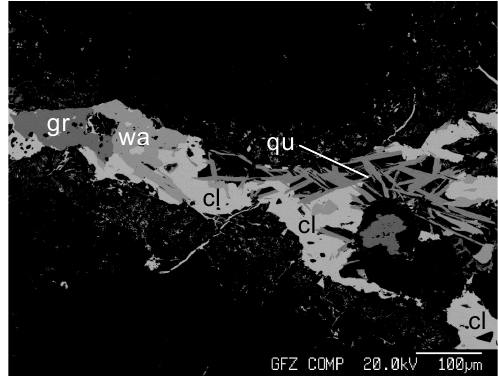
Figure 2. BSE image showing acicular grains of quijarroite (qu) in the matrix and intergrown with watkinsonite (wa) and clausthalite (cl), and associated with grundmannite (gr).